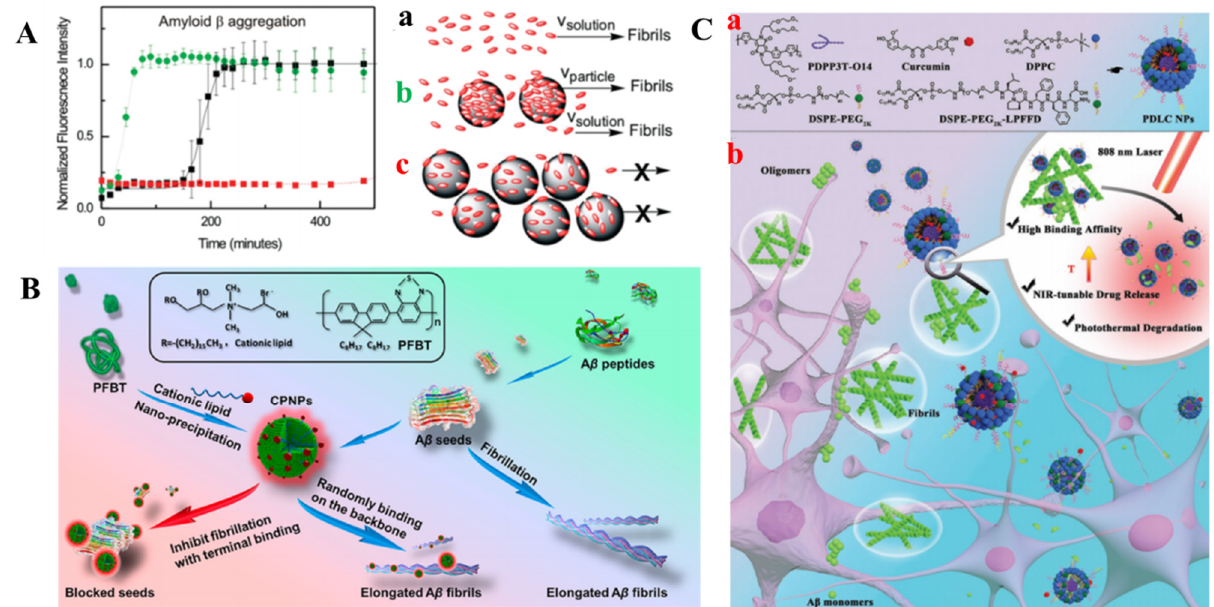
Figure 14. ( A ) Schematic of the dual effect of amino-modified polystyrene nanoparticles on A β fibrillation. (a) The fibrillation ofA β 1–40 in the absence of nanoparticles shows the typical nucleation-elongation profile. (b) The fibrillation process is accelerated (shorter lag phase) by nanoparticles at low particle concentration (c) At high particle concentration, the fibrillation process is retarded (longer lag phase). Reprinted with permission from reference [186]. Copyright 2010 American Chemical Society. ( B ) Schematic diagram of the procedures for CPNPs fabrication and A β 1–40 fibril inhibition with CPNPs. Reprinted with permission from reference [188]. Copyright 2019 American Chemical Society. ( C ) Schematic illustration of PDLC NPs for chemo-photothermal treatment for A β aggregation. (a) Chemical structures and the synthesis of PDLC NPs. (b) Schematic illustration of PDLC NPs-mediated chem-photothermal treatment by combining NIR light-tunable drug release and photodegradation of amyloid β . Reprinted with permission from reference [191]. Copyright 2019 American Chemical Society.